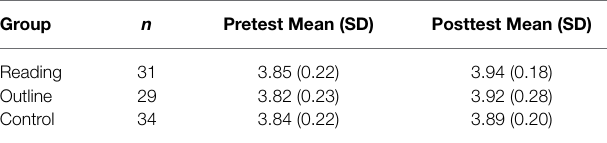
TABLE 2 | Descriptive statistics for coherence score by group and